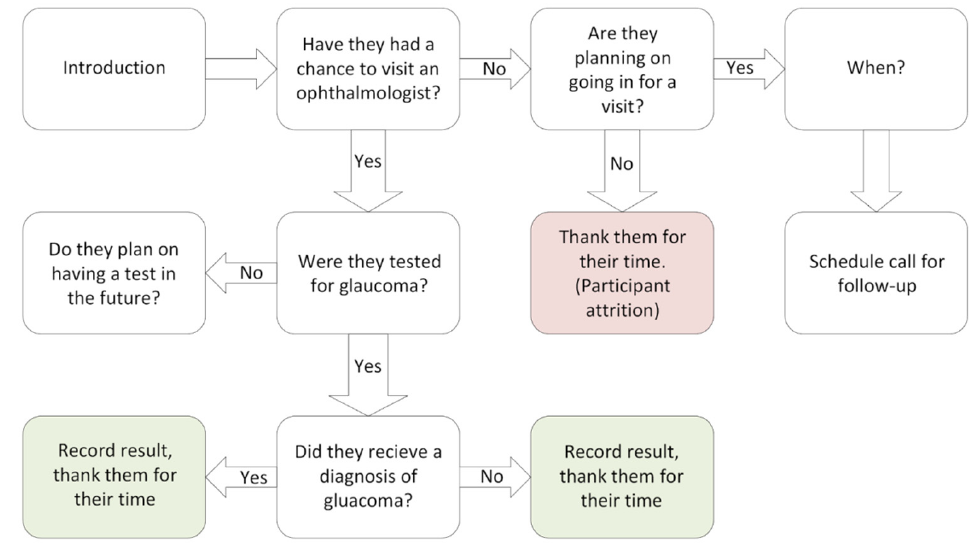
Figure 4. Flow chart of questions asked during the telephone call follow-up with participants.